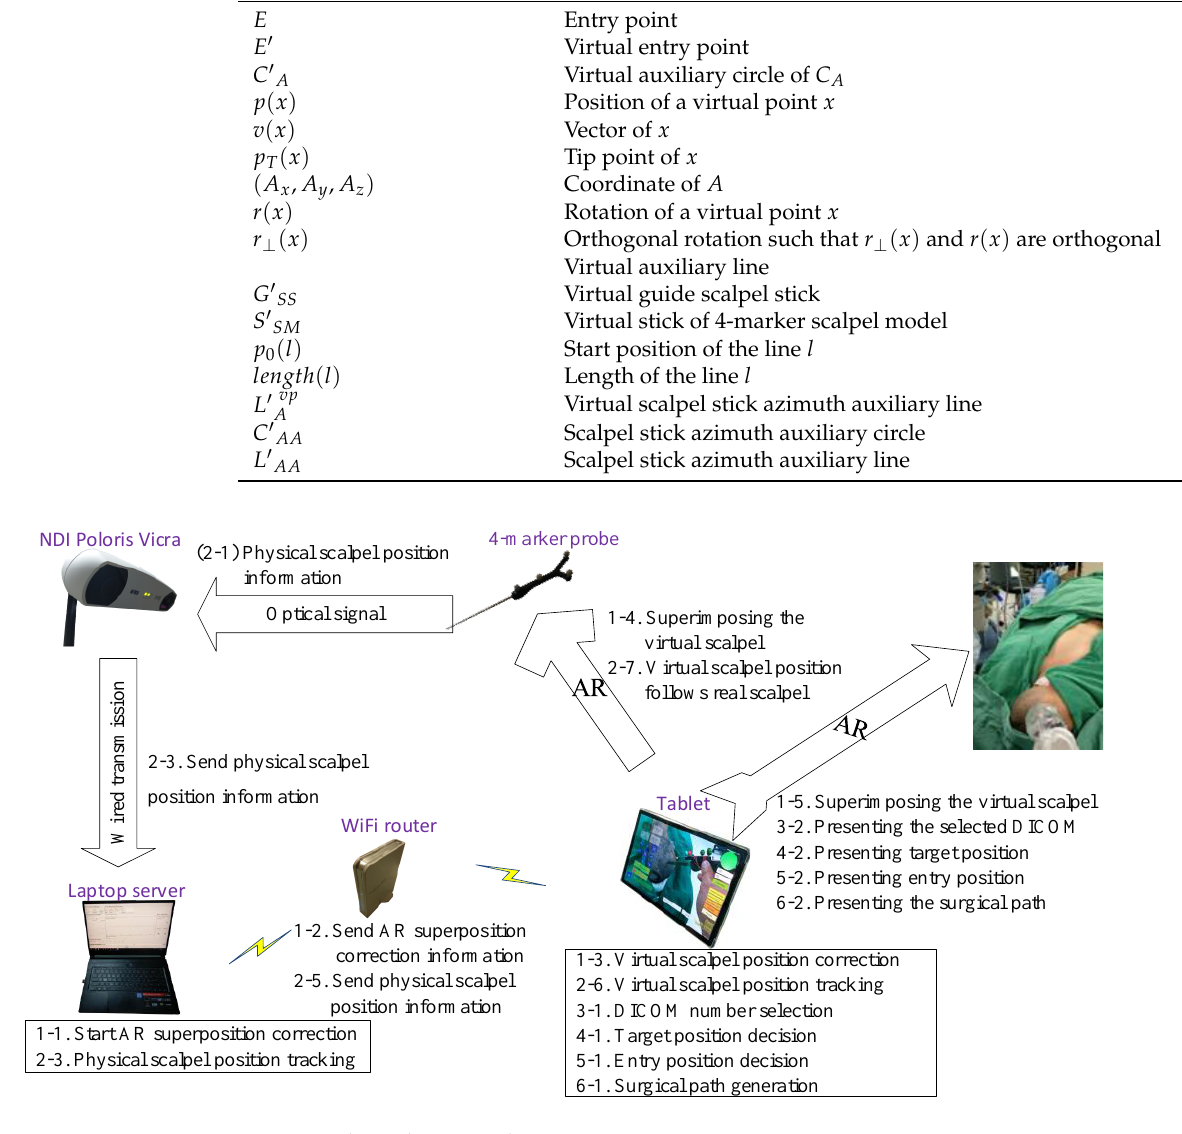
Figure 1. The architecture